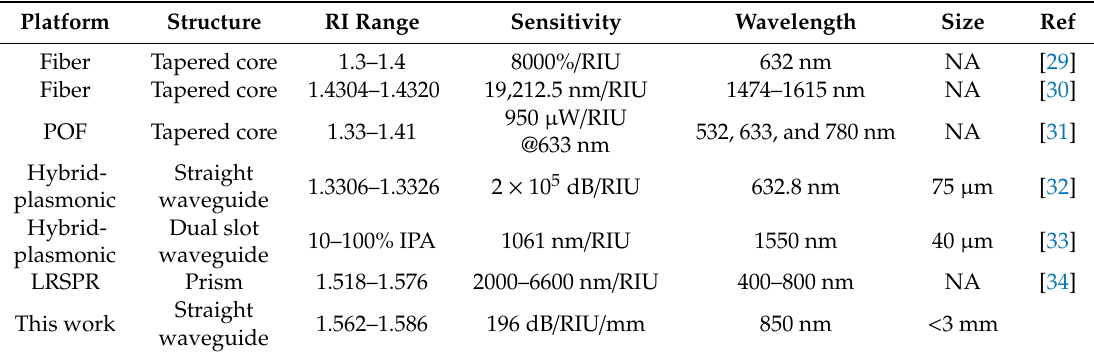
Table 2. RI sensing performance